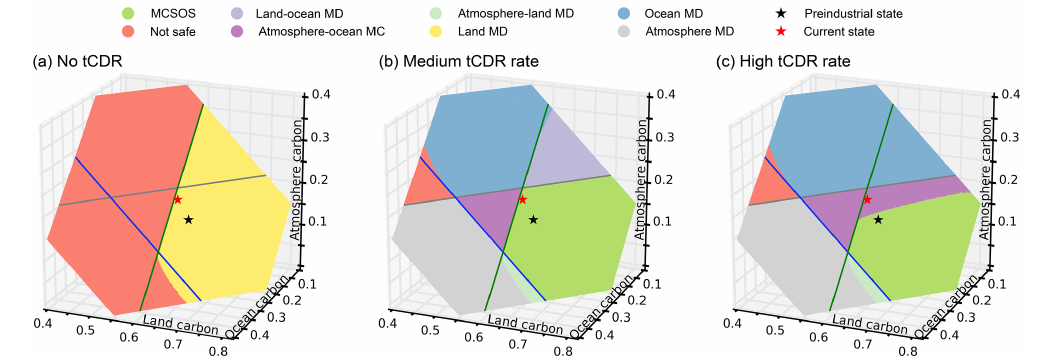
Figure 6. Charting of normalised carbon-system initial-condition state space in our model for three tCDR management characteristics with identical, relatively low-emission baseline ( c max = 0 . 2): (a) without tCDR ( α max = 0), (b) intermediate tCDR rates ( α max = 0 . 004) and (c) high tCDR rates ( α max = 0 . 04). The two-dimensional plane is formed by sampling initial conditions around the pre-industrial state (variation of carbon stocks by ± 0.2 while conserving total carbon in the system). Each domain is coloured according to transient properties of trajectories starting in different state space regions. For example, the MCSOS (i.e. safe domain) is formed by the initial conditions of “safe” trajectories, whereas red indicates the initial conditions of trajectories crossing all respective planetary boundaries at some point in the simulation. Lines indicate the associated planetary boundaries of atmosphere, land and ocean in grey, green and blue, respectively.